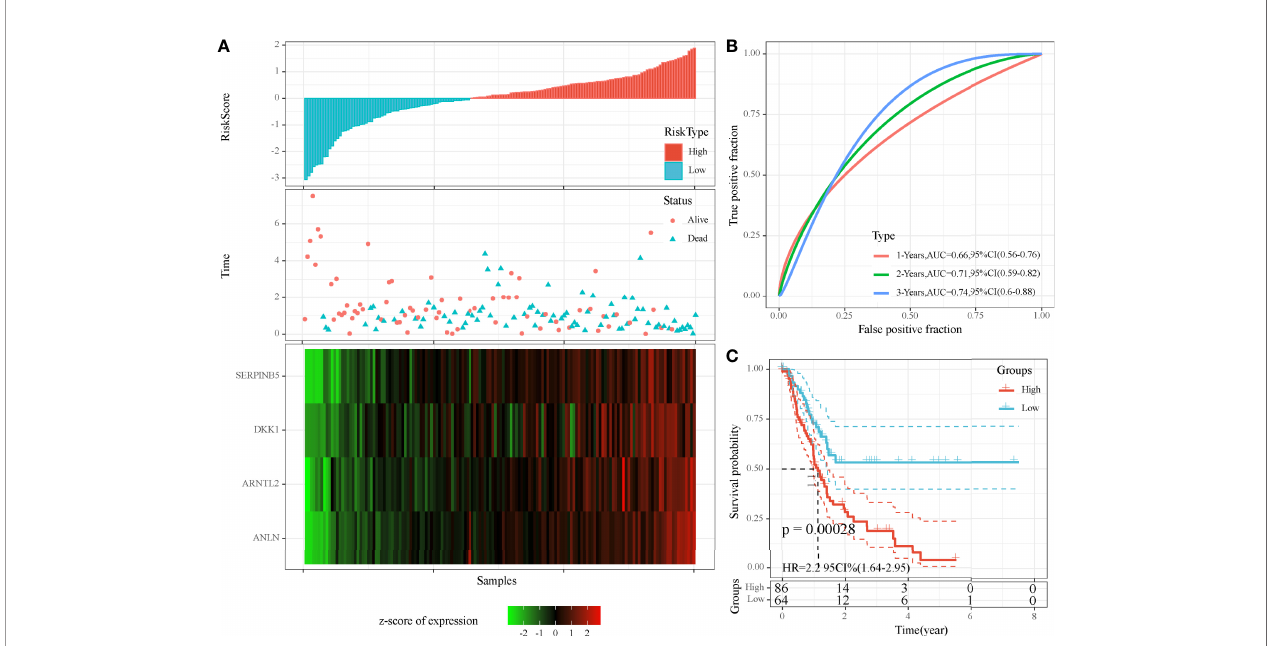
FIGURE 7 | Evaluation of the four-gene prognostic model in TCGA-PAAD cohort. (A) The distribution of PAAD samples and expression of prognostic genes ranking by risk score. (B) ROC curve of the prognostic model in predicting 1-, 3-, and 5-year overall survival. (C) Kaplan – Meier survival plot of high-risk and low-risk groups. Log-rank test was